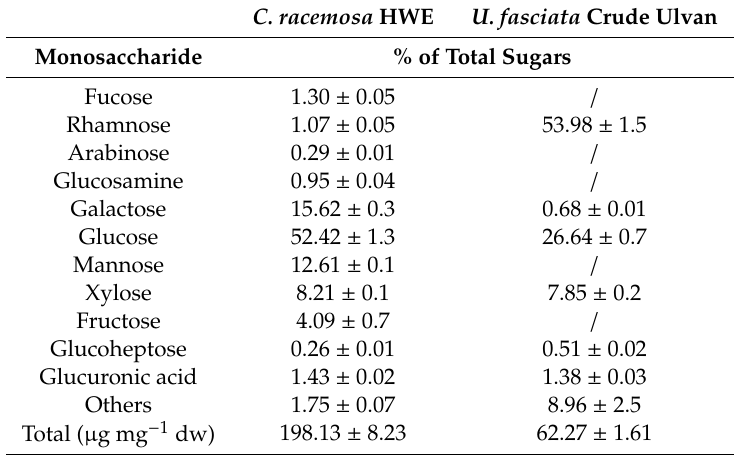
Table 4. Monosaccharide composition as a percentage of total sugars and total content of sugars ( µ g mg − 1 dw) in hot water extract (HWE) from Caulerpa racemosa and crude ulvan from Ulva fasciata